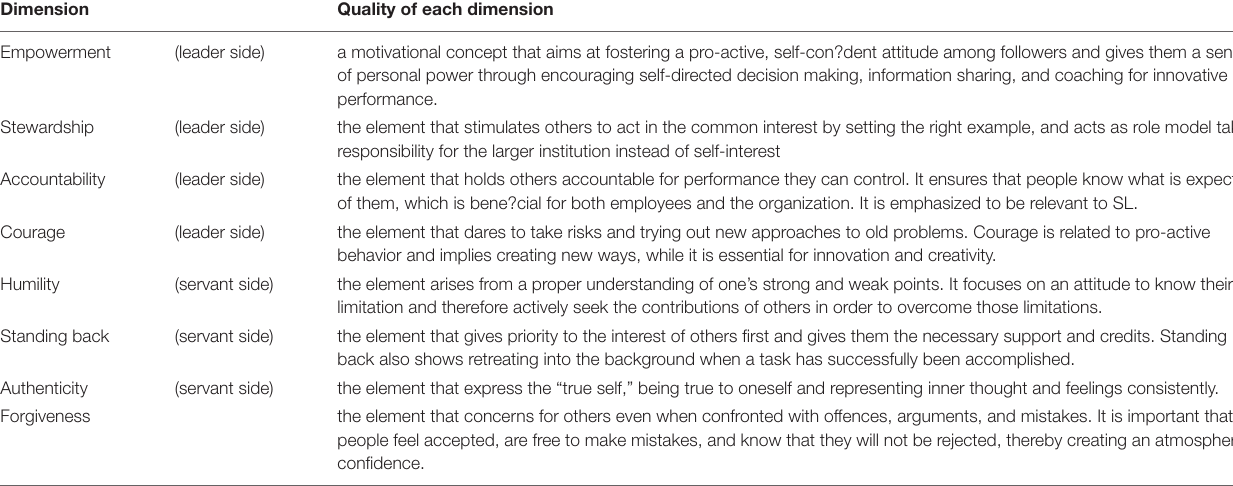
TABLE 1 | The contents of eight dimensions of SLS. Dimension Quality of each dimension Empowerment (leader side)